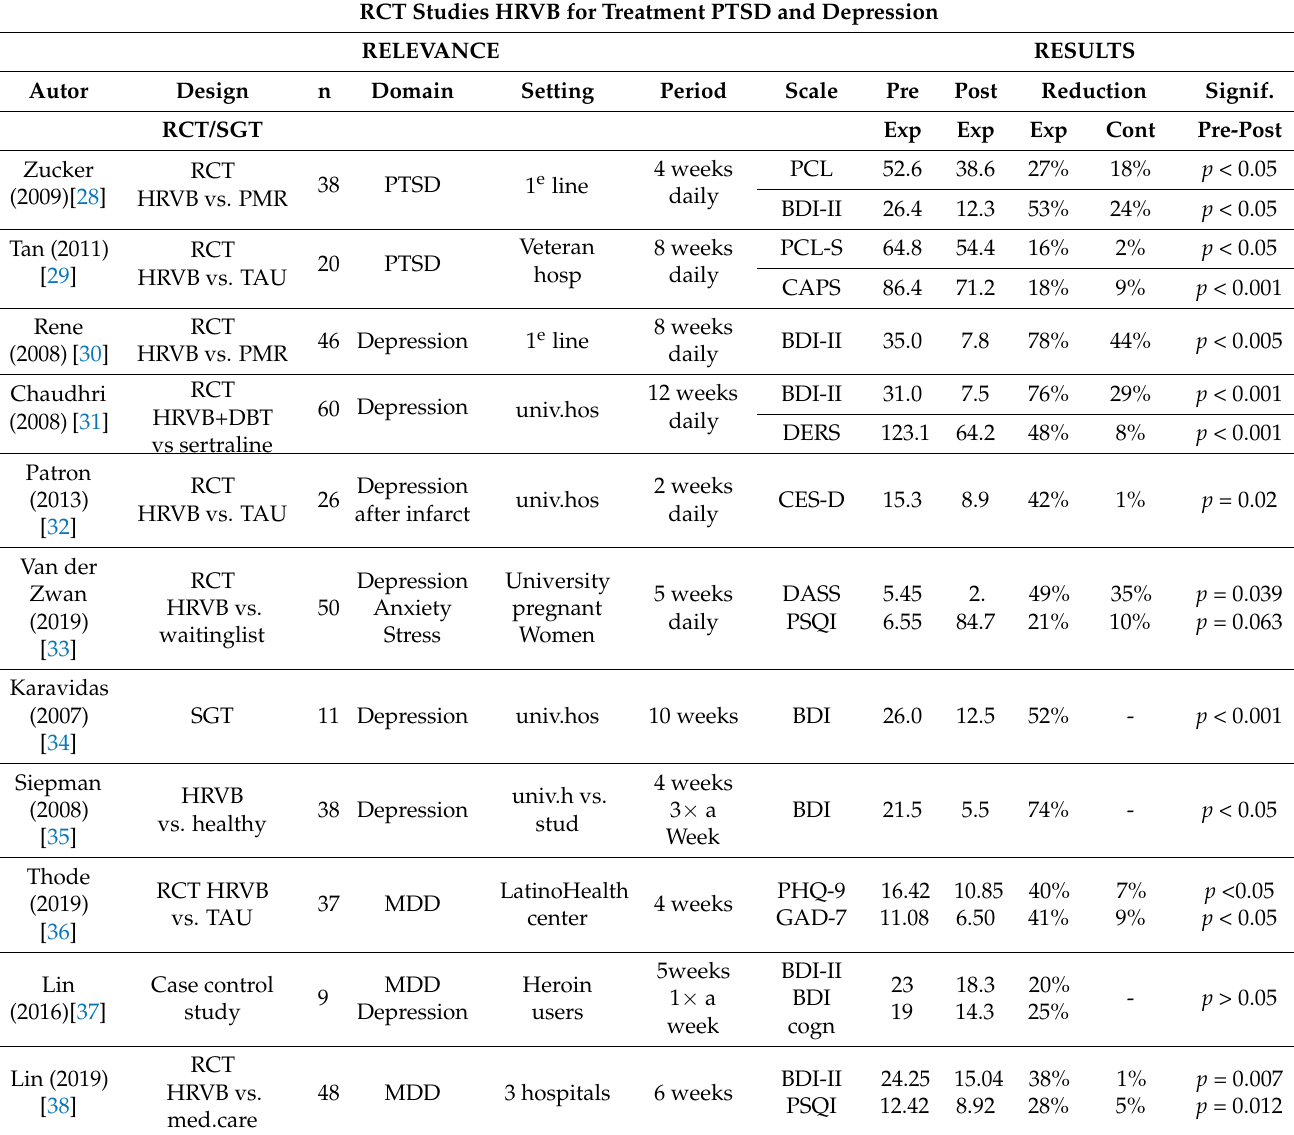
Table 1. The results of the selected